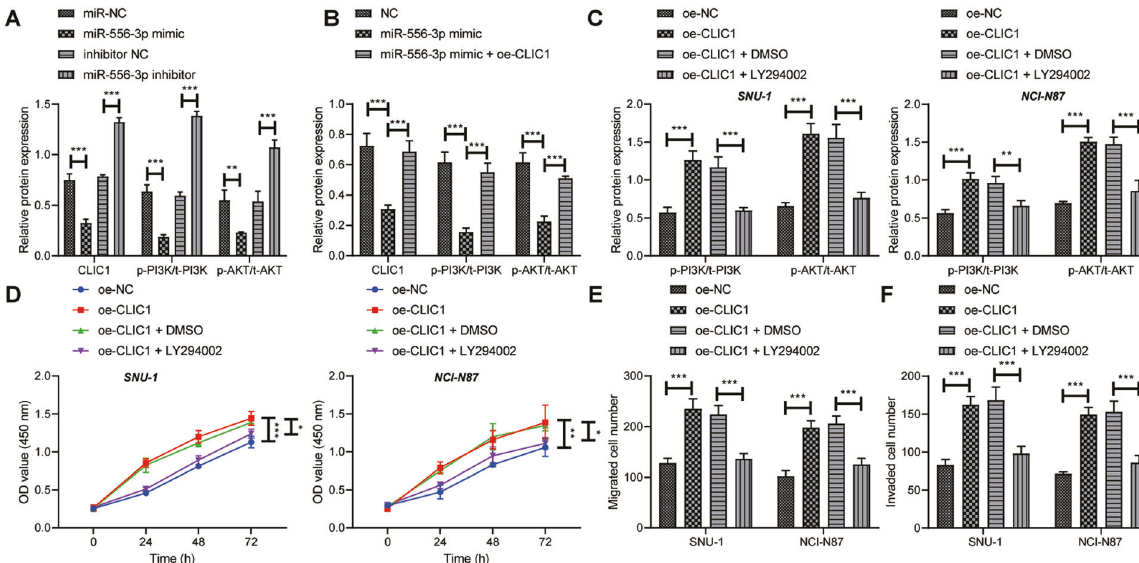
Fig. 7 miR-556-3p/CLIC1/PI3K/AKT axis manipulates the viability, invasion, and migration of GC cells. A The protein expression of CLIC1, PI3K, and AKT and phosphorylation of PI3K and AKT after overexpression or inhibition of miR-556-3p detected by Western blot analysis. B The protein expression of CLIC1, PI3K, and AKT and phosphorylation of PI3K and AKT after overexpression miR-556-3p and CLIC1 determined by Western blot analysis. C Western blot analysis was used to detect the effect of AKT inhibitor LY294002 on the protein expression of PI3K and AKT and phosphorylation of PI3K and AKT. D CCK-8 was used to detect cell proliferation. E Cell migration detected by Transwell assay. F The invasion of GC cells measured by Transwell assay. * represents the comparison between two groups. * p < 0.05; ** p < 0.01; *** p < 0.001. All experiments were repeated 3